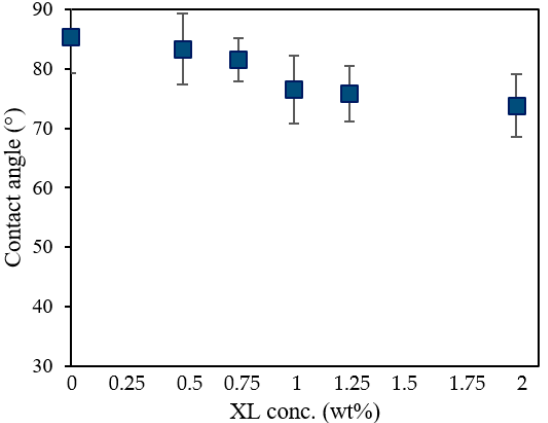
Table 3. Qualitative observation of the solvent stability of UV-cured PSf supports prepared with different cross-linker concentrations.